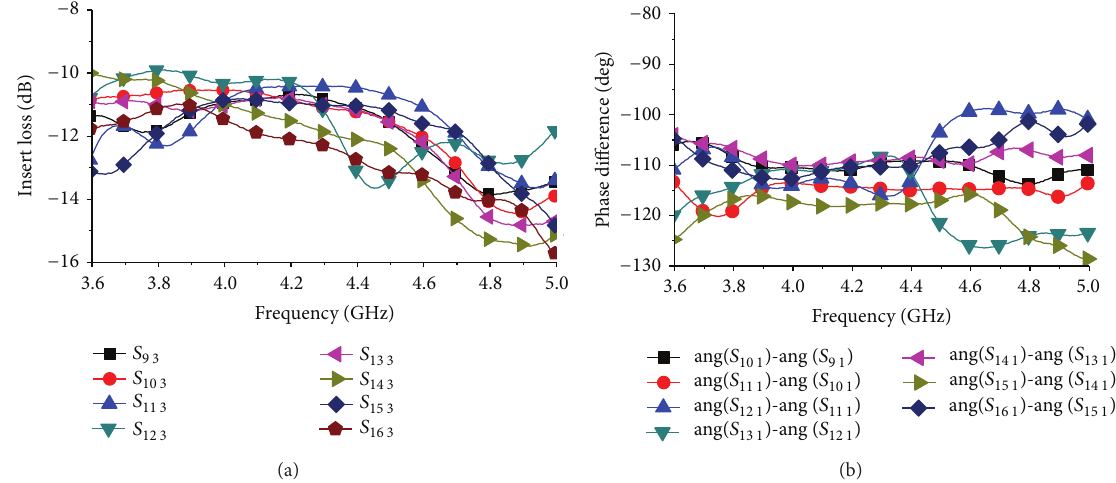
Figure 11: The measured results of insertion loss (a) and phase difference (b) at Port 3. The phase difference at Port 3 is − 112.5 ∘ theoretically.